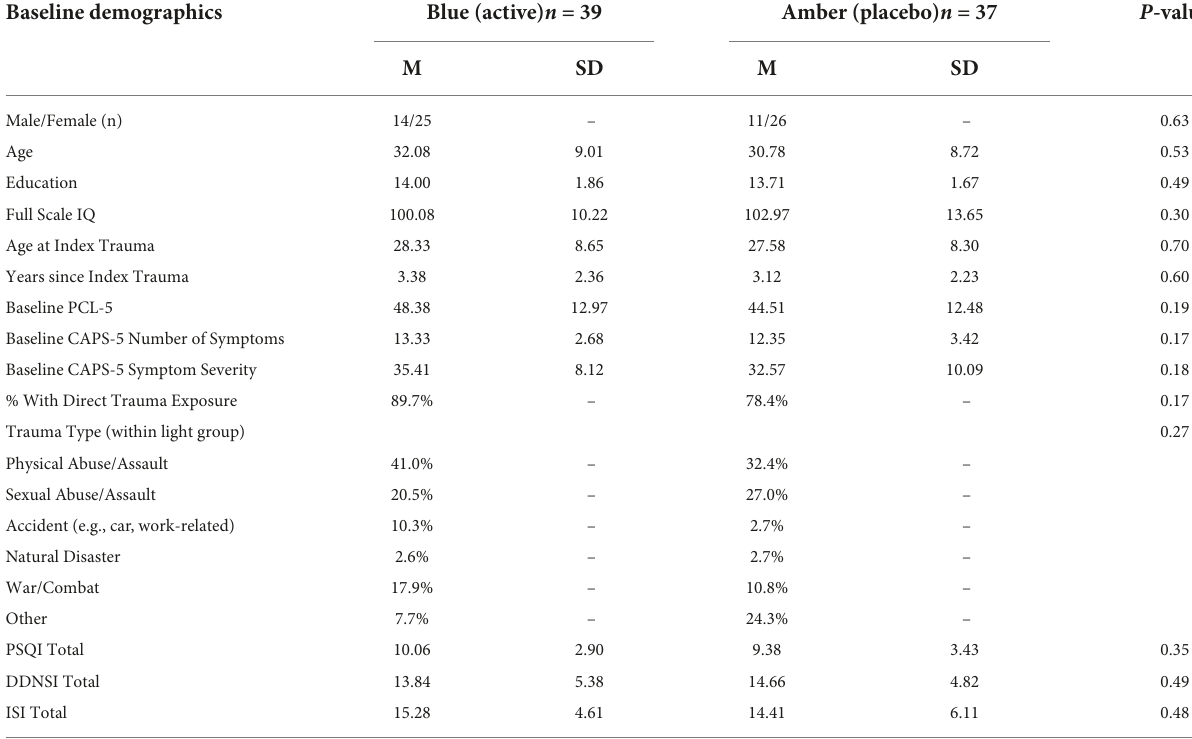
TABLE 1 Baseline demographic